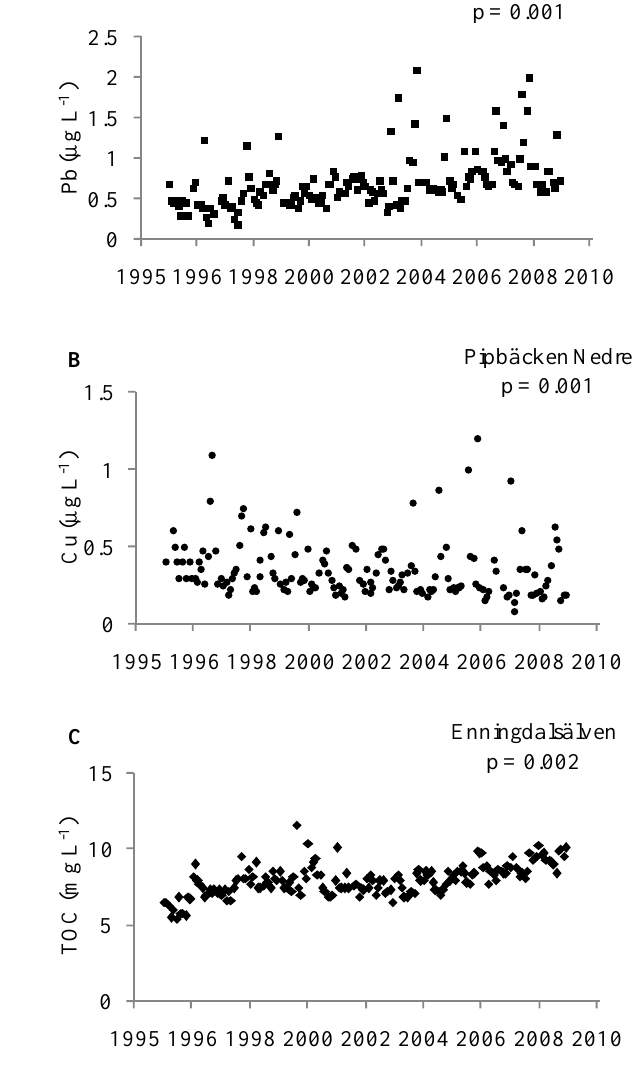
Fig. 2. Selected monitoring locations showing long-term raw-data series for Pb, Cu, and TOC. P values indicating trend significance are shown under the name of each site. per year (conc. yr − 1 ) for V did show a significant difference ( P = 0 . 0001). However, this difference was due to the large difference in concentration between the sites in the northern and southern regions, not a difference in trend